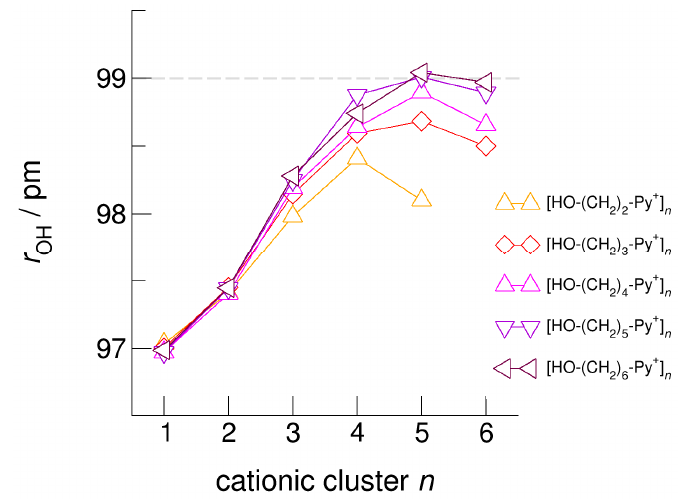
Figure 7. Average intramolecular bond lengths, r OH , for the cationic clusters [HO-(CH 2 ) x -Py + ] n with x = 2–6 and n = 2–6. For the clusters [HO-(CH 2 ) 6 -Py + ] n with the longest hydroxyalkyl chains, r OH , is elongated by 2 ppm due to enhanced cooperative hydrogen bonding. For comparison, we show the r OH bond distance of about 99 ± 1 pm measured for liquid methanol by means of neutron diffraction data (grey dashed line) [62].